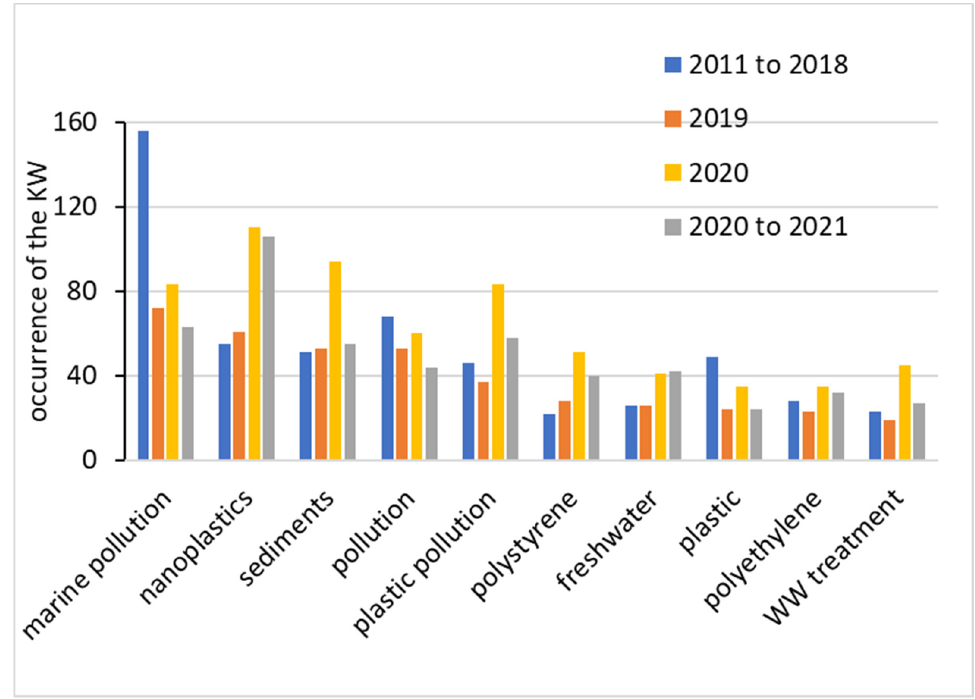
Figure 3. Trend of the occurrence of the main KWs that, other than microplastics, were repeated more than 5 times.